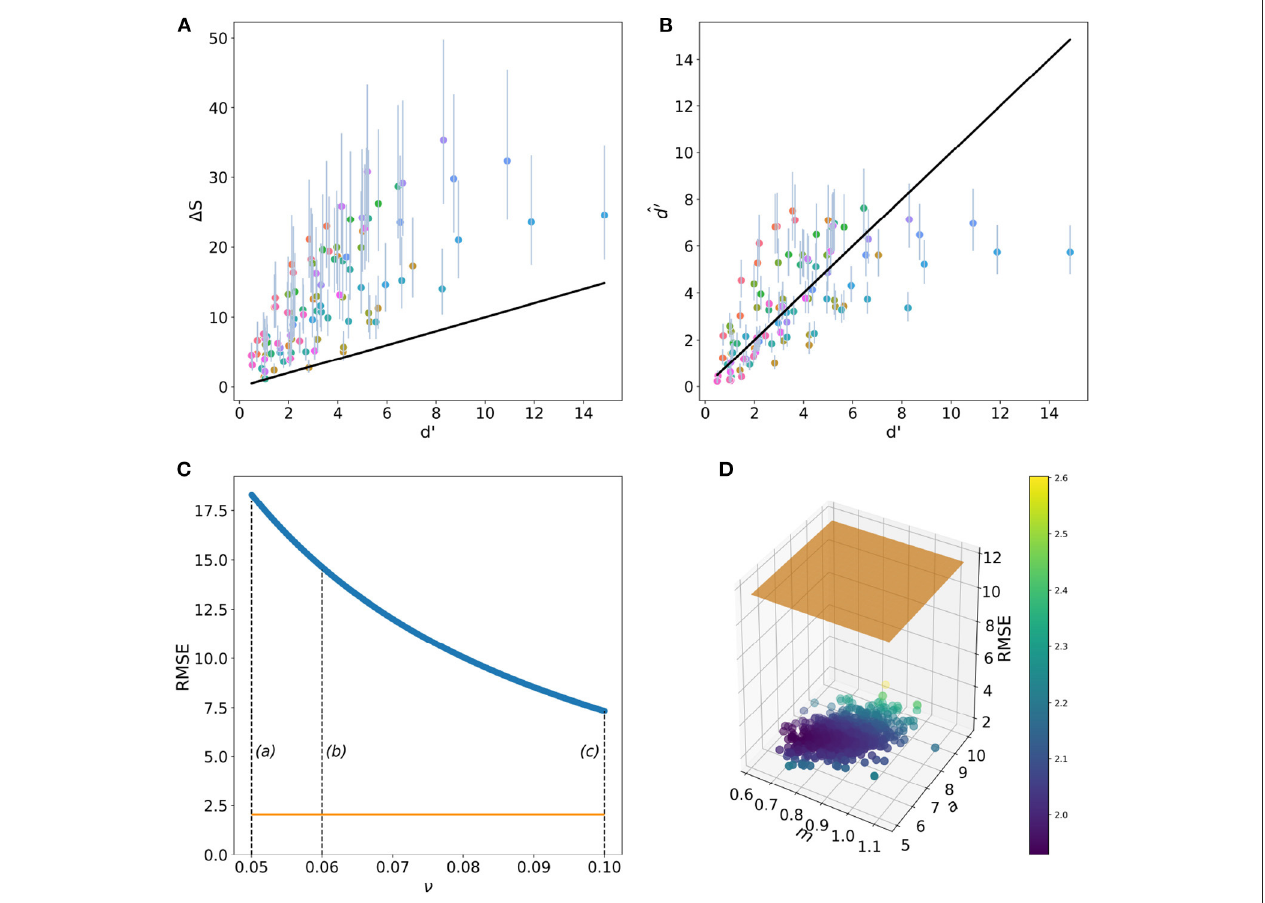
FIGURE 6 | Performance of the receptor-noise (RN) limited model (A) and the CDSF model (B) when predicting the outcome of Wright’s (1972) colour discrimination experiment (solid lines). Circular markers and vertical lines in panel A represent the mean and 95 % confidence intervals (CI) of 1 S values from 100,000 predictions of the colour discrimination experiments by Wright (1972) using Weber fraction values ( ν ) ranging from 0.05 to 0.1. Markers and vertical lines in (B) represent mean and 95 % CI d ′ values predicted by the CDSF model ( ˆ d ′ ) after evaluating the 100,000 coefficients present in the posterior distributions for the fixed terms a and m in Equation (4) for the same stimuli. Root mean square error (RMSE) for the predictions of the RN (C) and CDSF (D) discrimination functions. (C) Shows how the RMSE for RN diminishes as the noise parameter departs from ν 0.05. Dashed lines in (C) indicate the magnitude of Weber fraction values typically reported in the literature: = 0.06 (Olsson et al., 2015), and (c) ν 0.1 (Vorobyev and Osorio, 1998; Lind et al., 2014). The orange line indicates the (a) ν 0.05 ( Endler and Mielke, 2005), (b) ν = = = mean RMSE value corresponding to the CDSF function for the same colour differences. (D) Shows a 1,000 RMSE values sub sample out of the total 100,000 RMSE values obtained after evaluating the CDSF function with all the a and m parameters making up the posterior distributions recovered from the Bayesian fitting procedure. Marker colour represents RMSE value as indicated by the colour bar. Orange plane represents the mean RMSE value for the RN model for the same set of